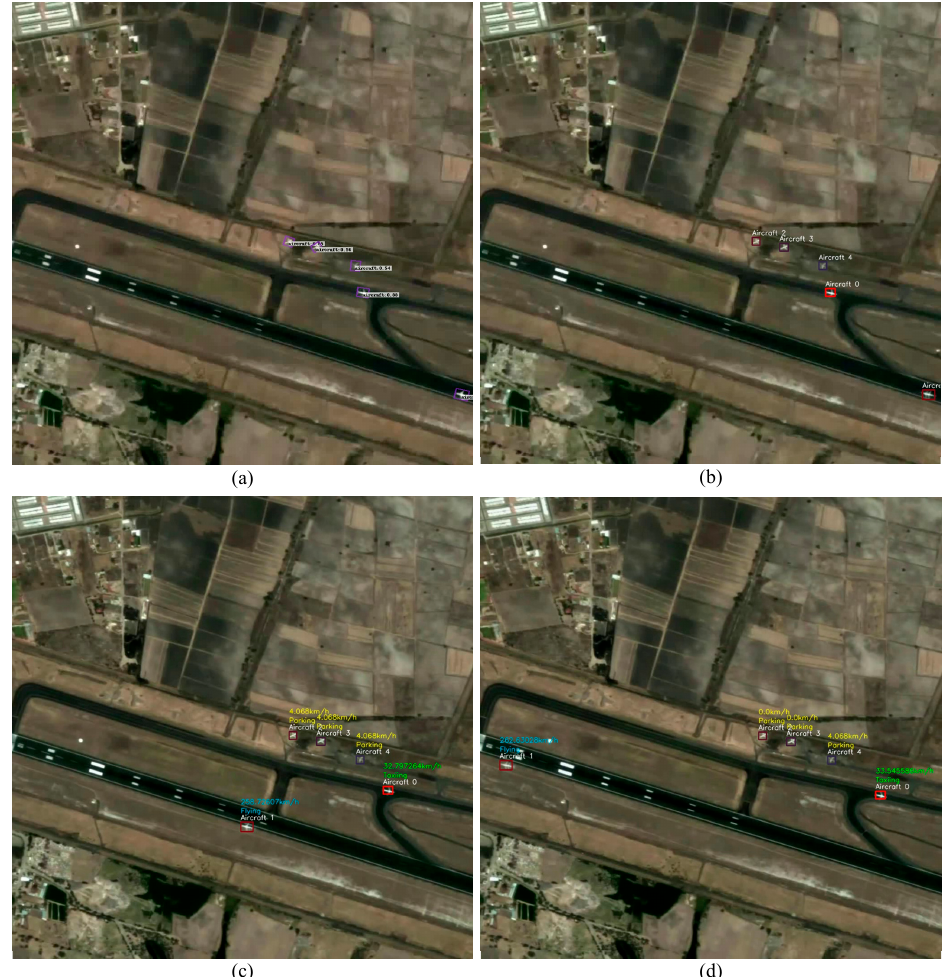
Figure 9. Screenshots of the experimental results from test Video 1. (a) Aircraft detection results in the first frame of the video; (b) Aircrafts detected in the starting frame are all tracked stably; (c) The speed of each tracked aircraft is measured and from this the type of aircraft activity is determined; (d) Each aircraft is stably tracked and its type of activity is determined.